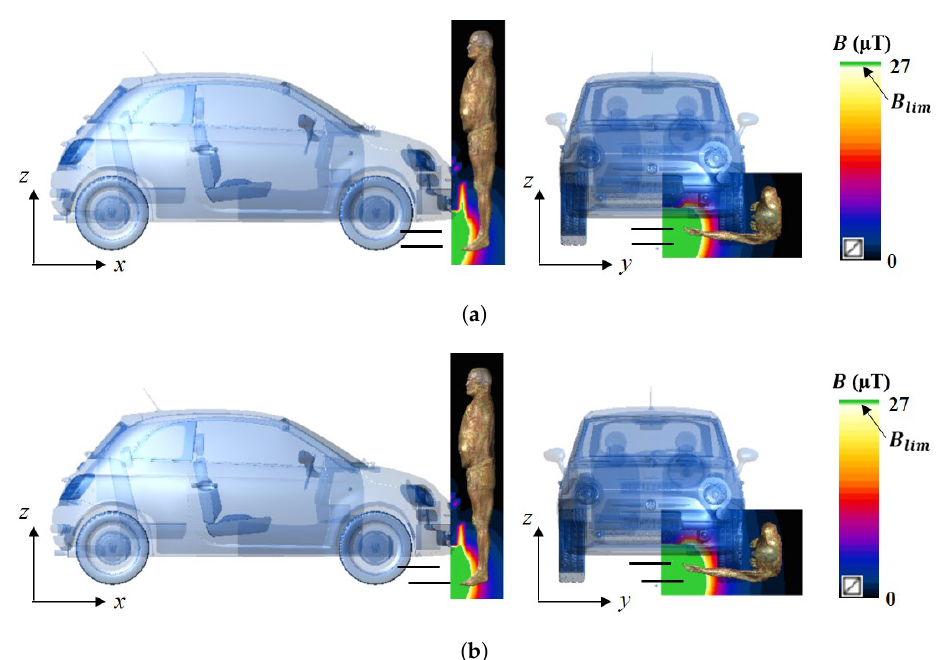
Figure 4. B -field distributions for exposure scenario #2 in the aligned ( a ) and misaligned ( b ) coil positions. B lim is the RL = 27 µ T (the green area is the portion where the RL is exceeded).